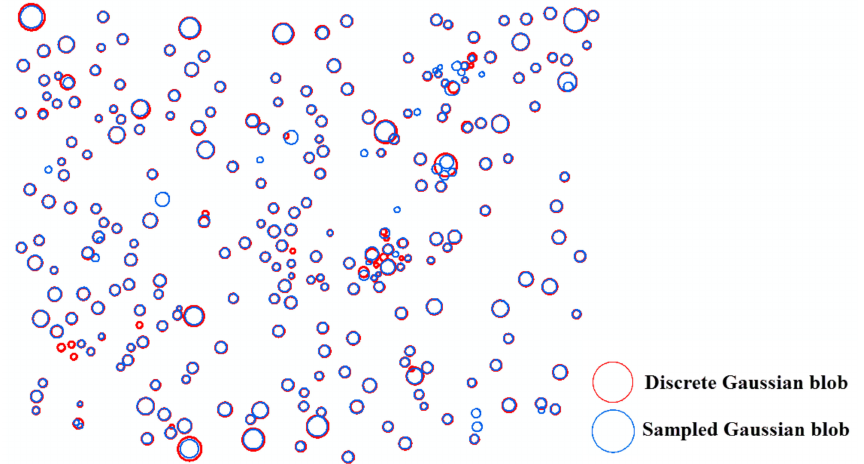
Figure 11. Di ff erences between sampled and discrete Gaussian scale-space blob detection for the oil palm orchard.